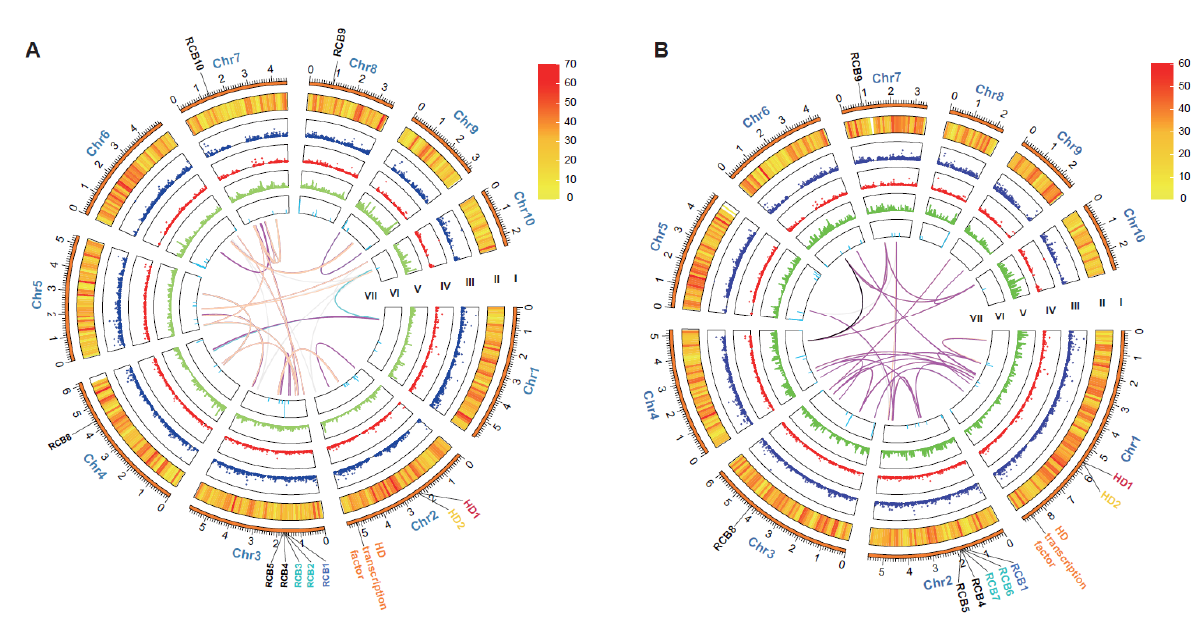
Figure 1. Global view of two haploid genomes within a dikaryotic cultivar of Lentinula edodes . ( A ) the SP3 genome. ( B ) the SP30 genome. The gene names marked outside the circle were annotated as mating-type-related genes; homeodomain (HD) , pheromone receptor (RCB). Circle I represents the 10 pseudo-chromosomes of L. edodes (Mb). Circle II represents annotated gene density on each pseudo-chromosome in 100-kb non-overlapping windows. Circle III represents SNP positions of alleles on two the monokaryons, and each point signifies one SNP. Circle IV represents indel positions of alleles on the two monokaryons, and each point means one Indel. Circle V represents the density of repetitive sequences on each pseudo-chromosome in 10-kb non-overlapping windows. Circle VI represents rRNA, snRNA, and tRNA densities on each pseudo-chromosome in 10-kb non-overlapping windows. Circle VII represents intra genomic collinearity. Peachpuff lines mean collinearity genes have been annotated by both InterPro and KEGG; Magenta lines mean collinearity genes have been annotated by InterPro; Cyan lines mean collinearity genes have been annotated by KEGG; Grey lines means hypothetical proteins. Table 1 . Genome assemblies of two monokaryons of Lentinula edodes . Contents